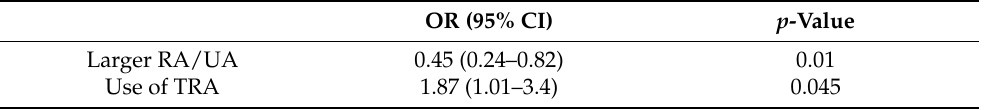
Table 5. Logistic regression analysis: independent factors for strength reduction in used hand for CAG/PCI.